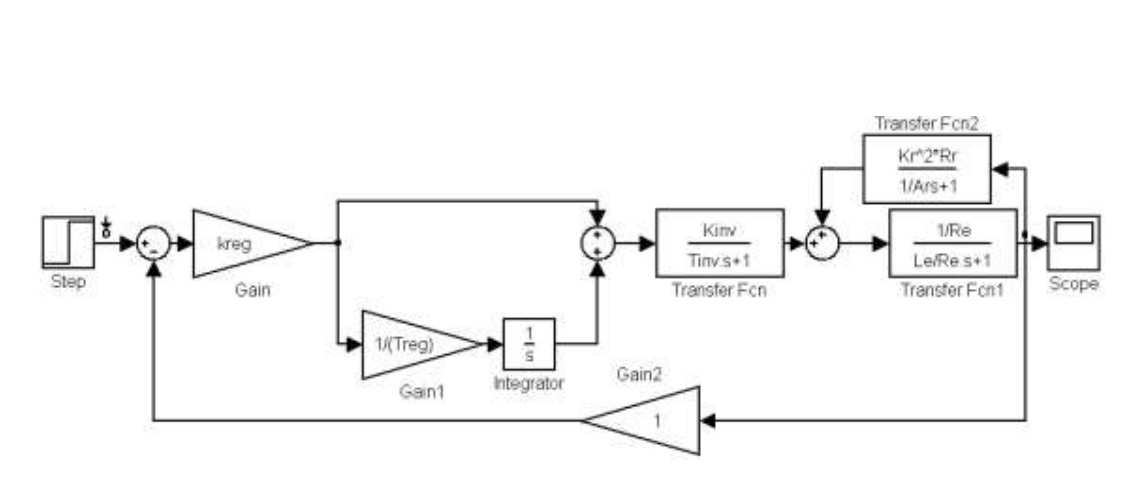
Figure 3 . Current loop simulation model for stator current component i sx control